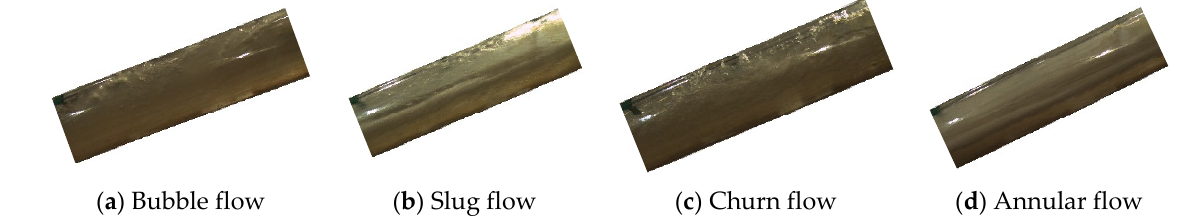
Figure 2. Flow pattern observed in the experiment at an inclination angle of 30°.